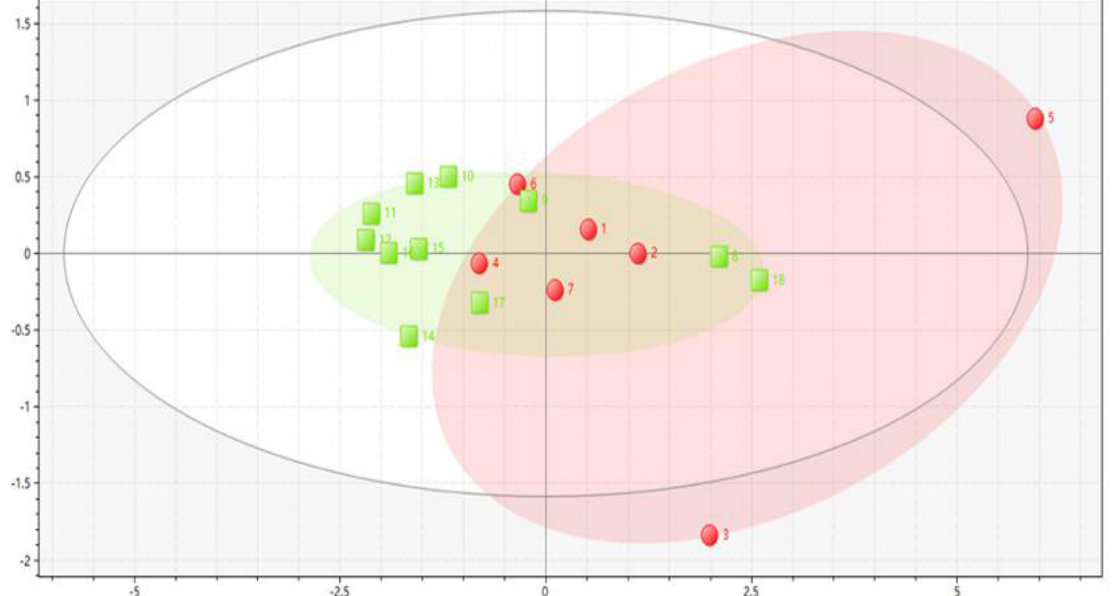
Figure 3. Principal component analysis (PCA) results for the 18 batches of samples.